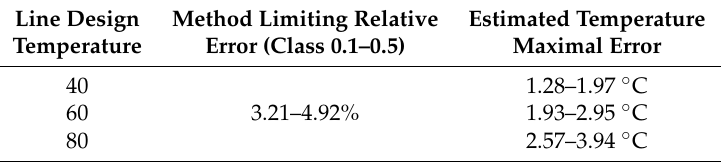
Table 8. Mean absolute error for standard design temperatures of power lines at the sampling rate of 30